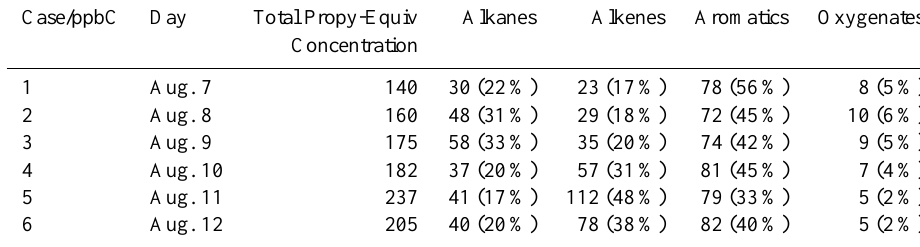
Table 1. Daily averaged chemical parameters for six cases in the NCAR MM